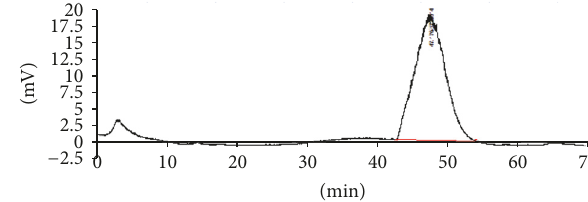
Figure 2: Chromatography of JP1 by HPGPC.